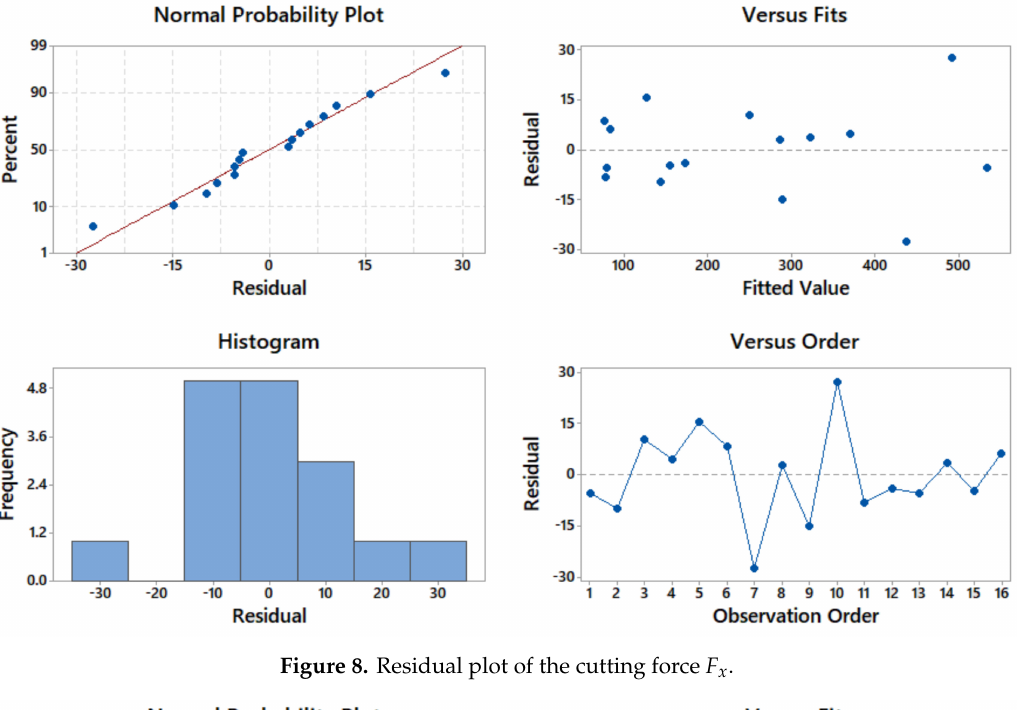
Figure 8. Residual plot of the cutting force F x .